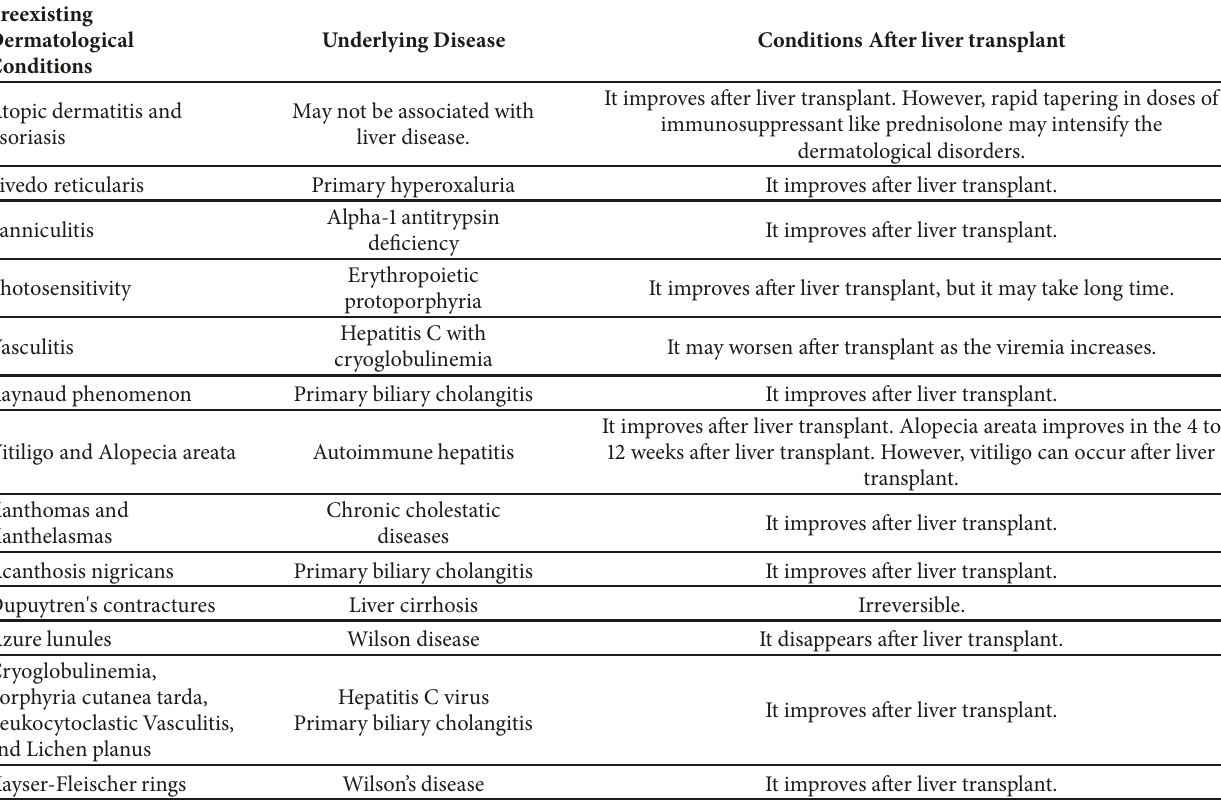
Table 1: Preexisting dermatological conditions after liver